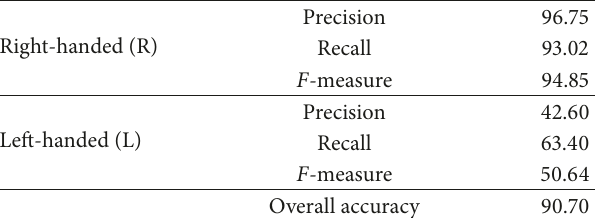
Table 4: Performance results for handedness classification on IAM database.